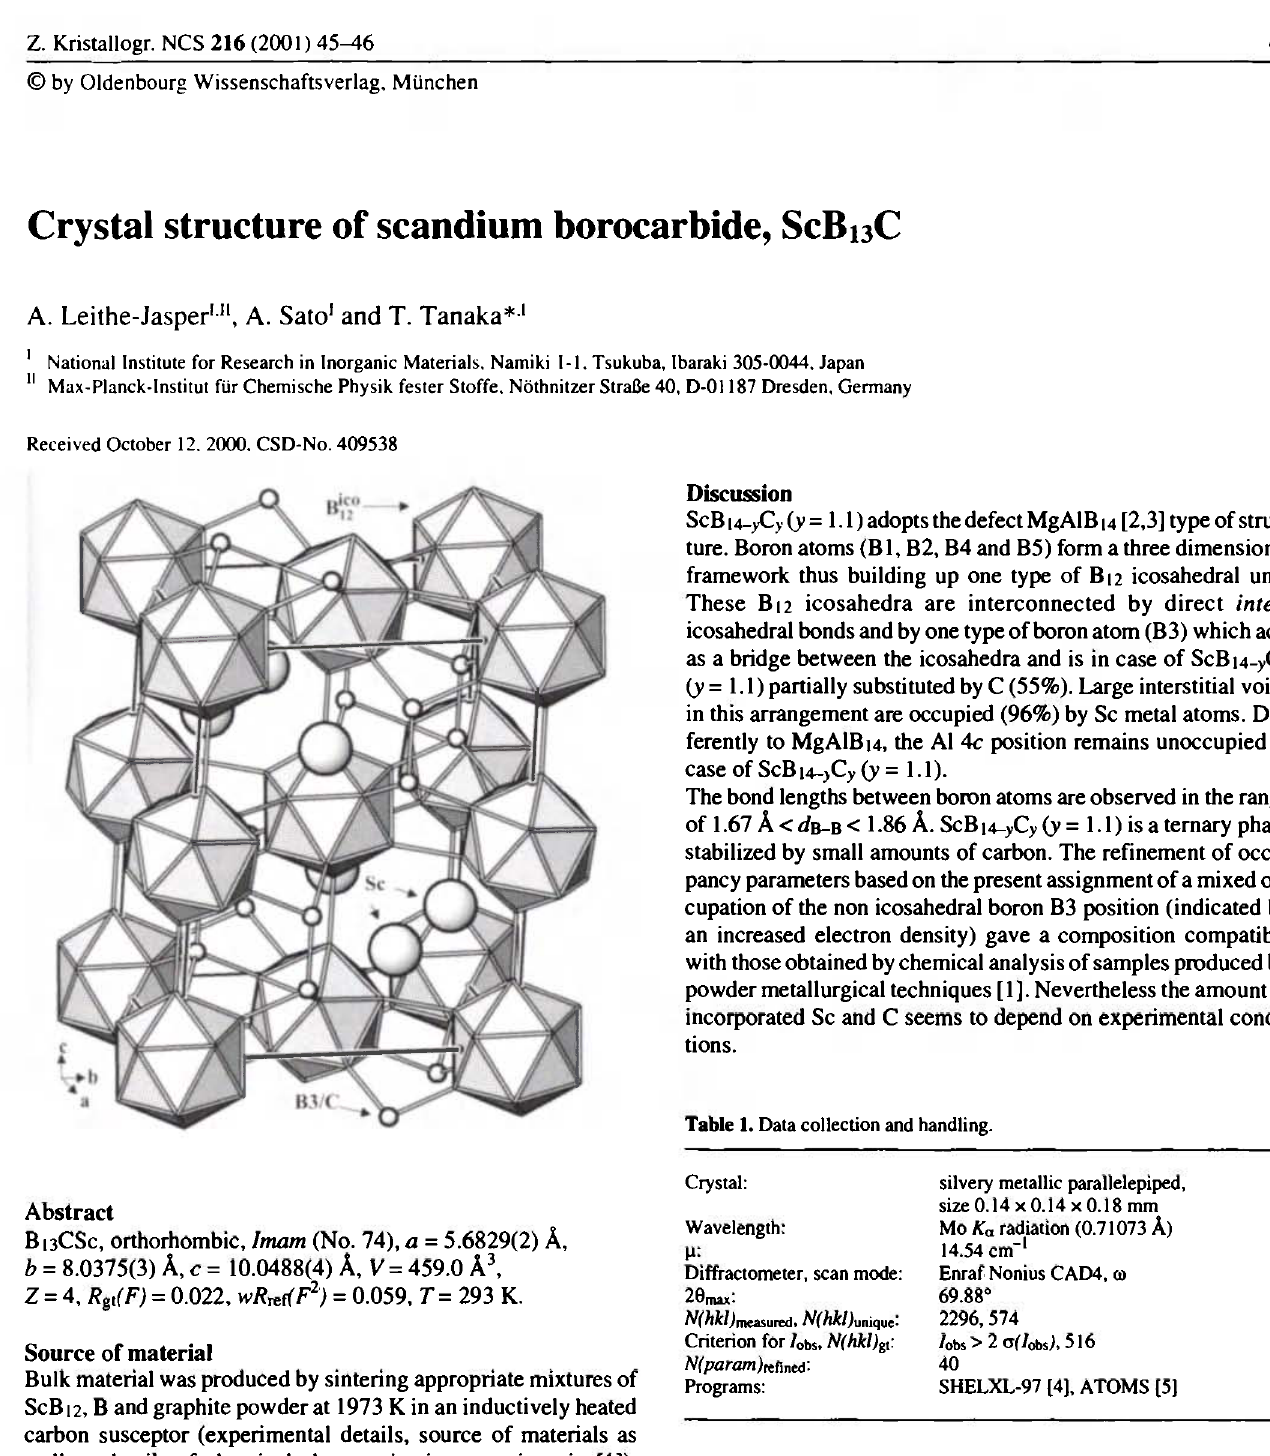
Table 2. Atomic coordinates and displacement parameters (in A 2